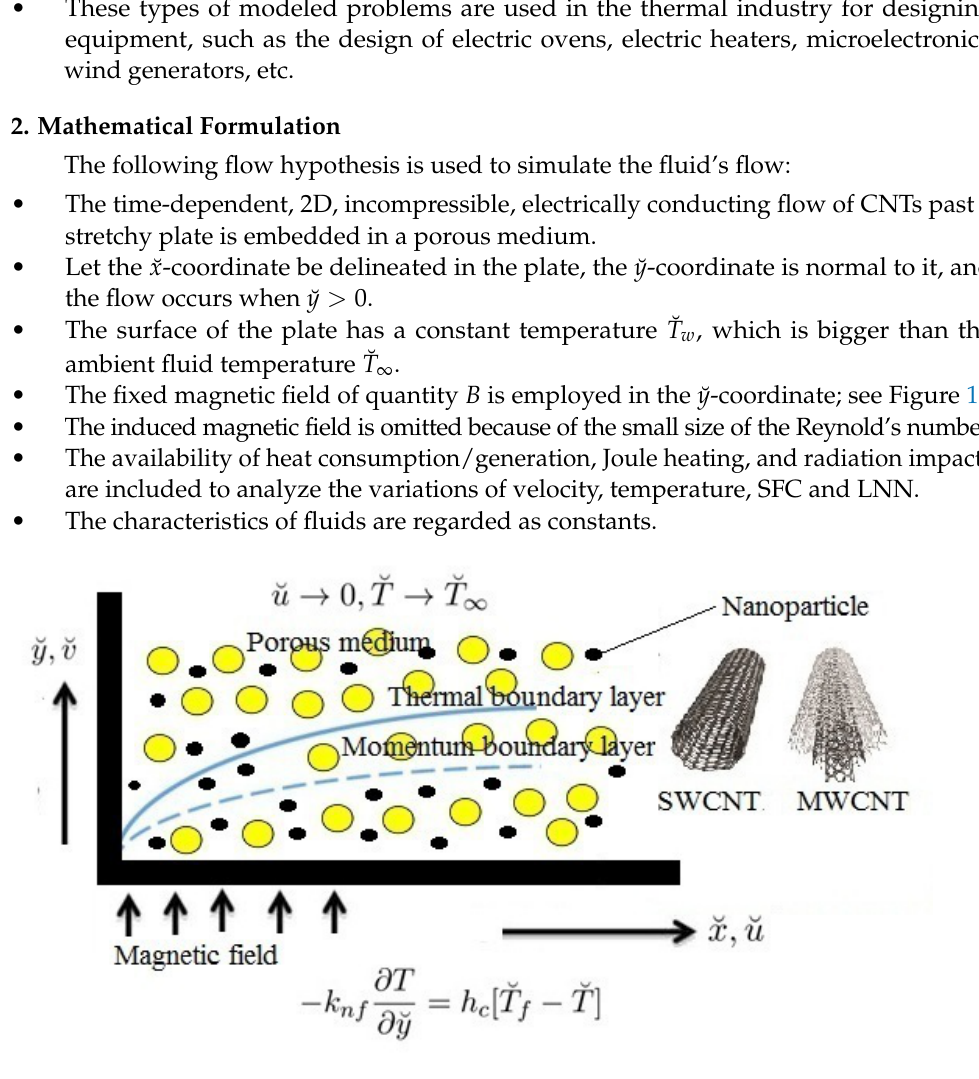
Figure 1. Physical configuration of the flow